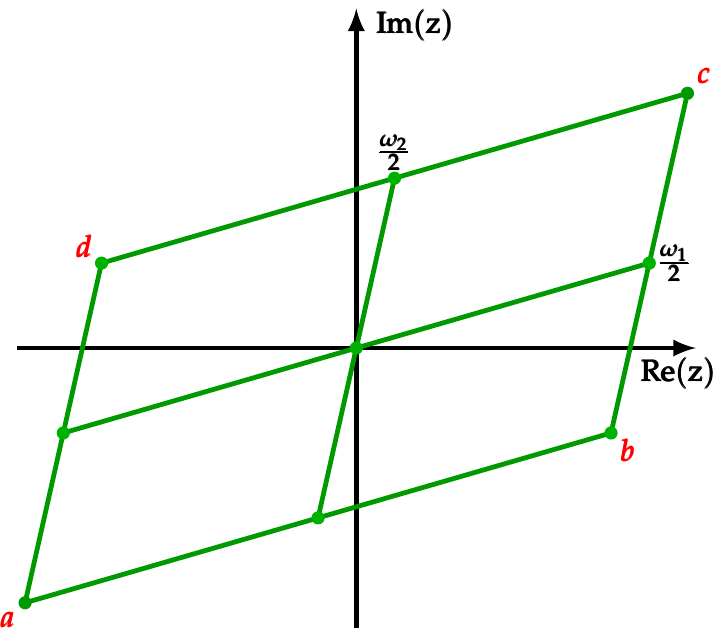
Figure 16. Fundamental parallelogram.